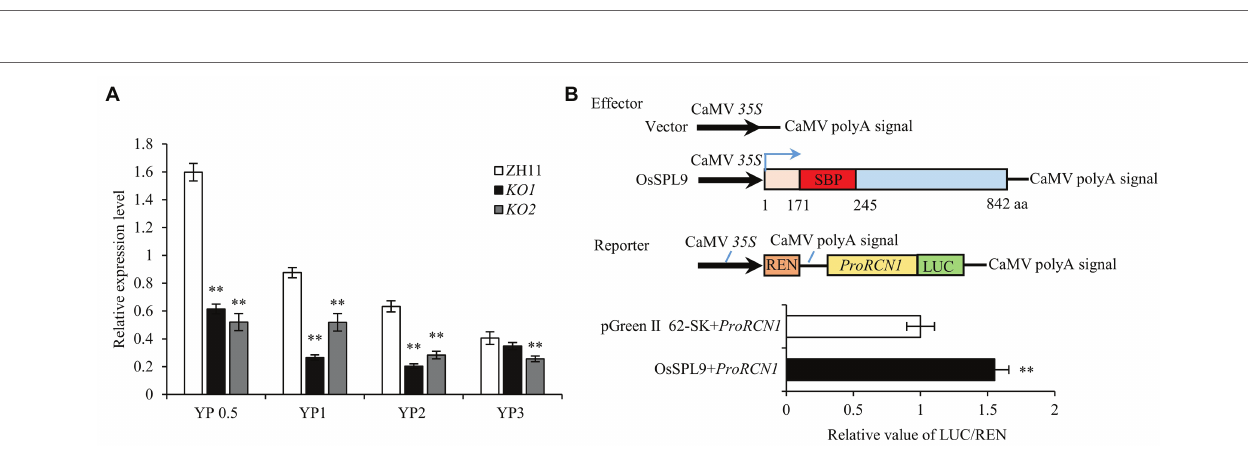
FIGURE 4 | OsSPL9 activates the transcription of rice TERMINAL FLOWER 1/CENTRORADIALIS homolog ( RCN1 ). (A) The transcriptional levels of RCN1 were downregulated in young panicles in KO mutants. YP0.5, YP1, YP2, and YP3, young panicles of 0.5, 1, 2, and 3 cm in length, respectively. Data are given as means ± SD of three biological replicates. ** indicates p < 0.01 by Student’s t -test. (B) Luciferase transient transcriptional activity assay in rice protoplasts to show that OsSPL9 activates RCN1 promoter. The pGreen II 0800-LUC/Renilla luciferase (LUC/REN) ratio of empty vector and proRCN1 ::LUC was normalized to 1. Data are given as means ± SD of three biological replicates. ** indicates p < 0.01 by Student’s t